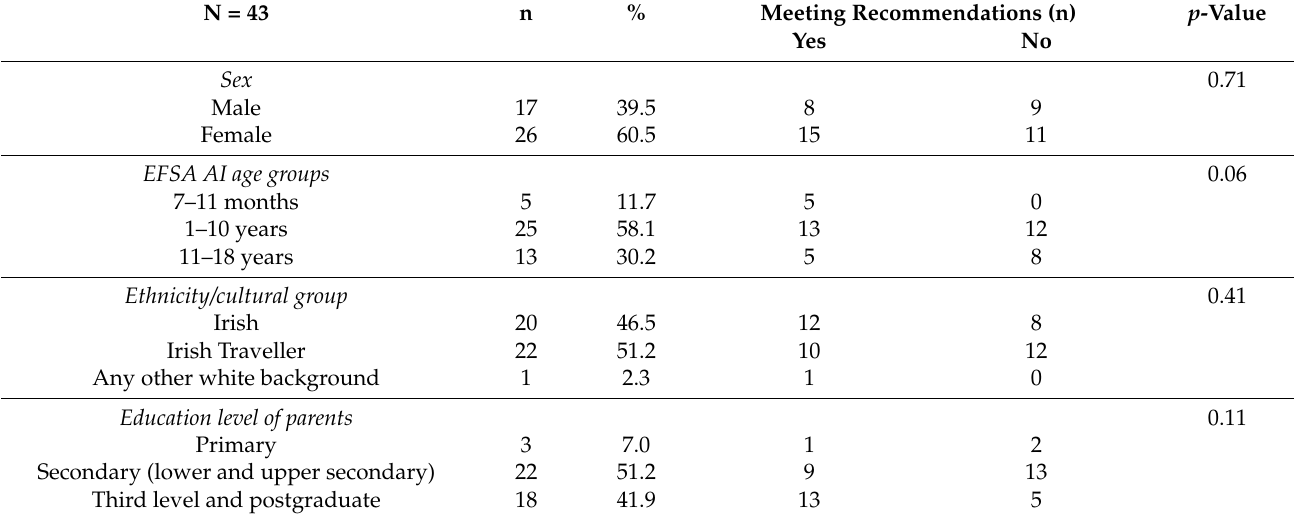
Table 2. Sample demographic characteristics and significant differences between demographics and meeting EFSA AI iodine